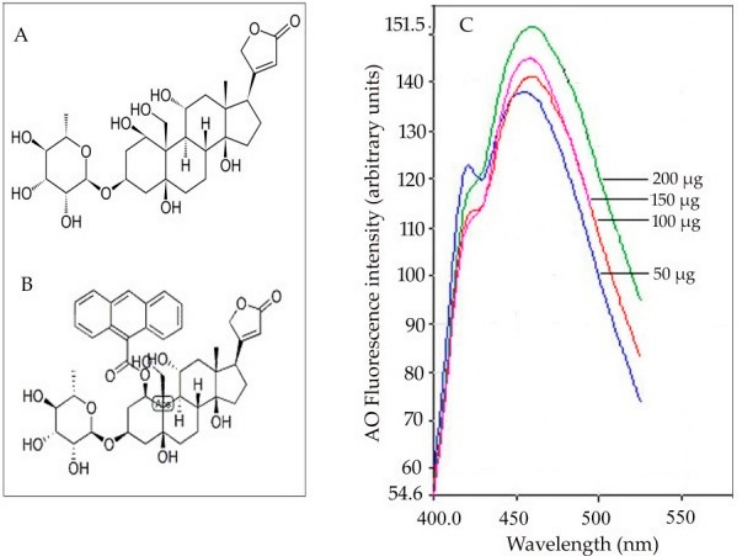
Figure 3. ( A ) Chemical structure of ouabain and ( B ) its fluorescent derivative 9-anthroylouabain. ( C ) Dose-dependency (protein concentration ranging from 50 to 200 µg) of fluorescence intensity obtained from the fluorescence emission spectra due to OU-sensitive ATPase binding to 9-anthroylouabain (ex. 365 nm, em. 460 nm) [85].